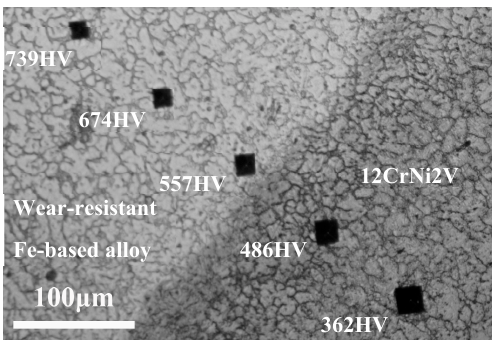
Figure 8. Microhardness profile along the melt depth of the laser melting deposited Fe-based alloy gradient materials.